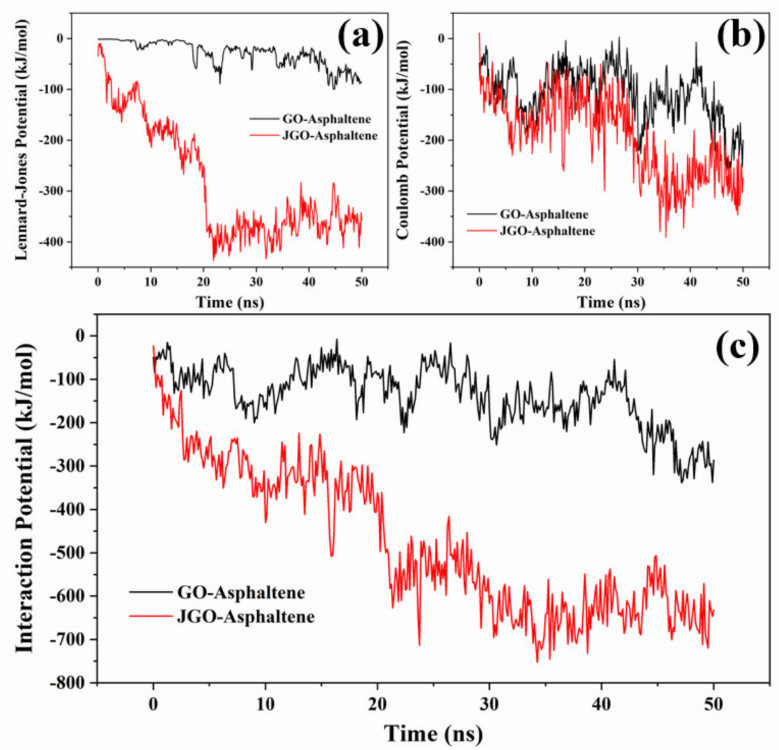
Figure 8. Intermolecular interaction energy between GO/JGO and asphaltene at the oil/water interface: Lennard–Jones potential ( a ), Coulomb potential ( b ), and total interaction energy ( c